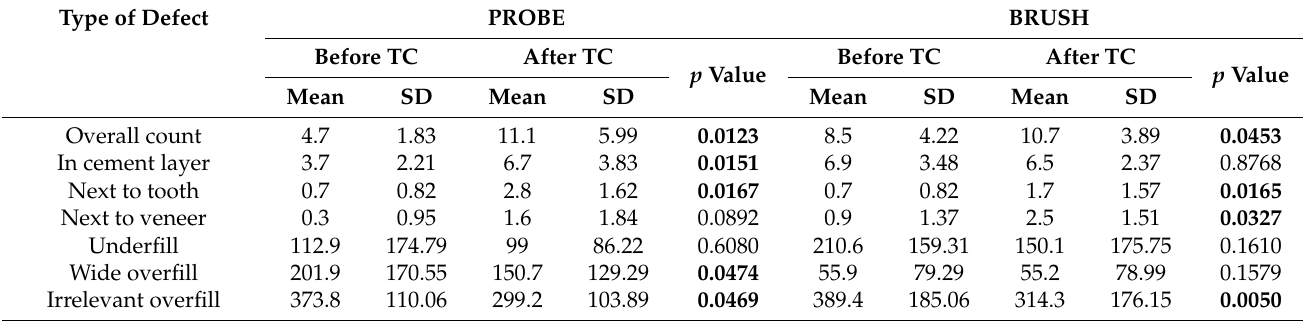
Table 2. Localization and character of defects in two groups before and after thermocycling.